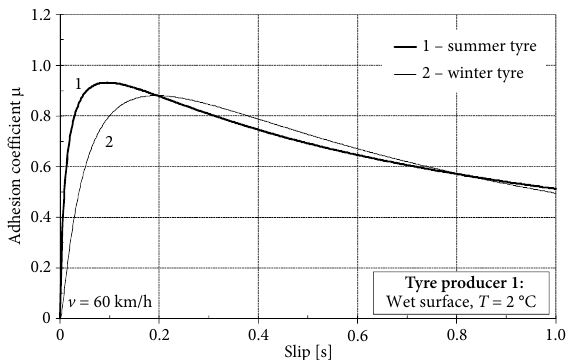
Table 5. Differences in slip referring to m peak adhesion coefficient